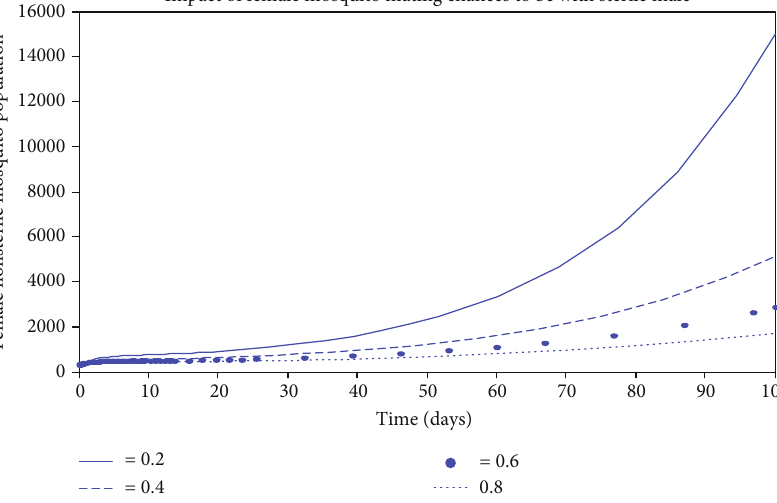
Figure 2: Impact of female mosquito mating probability ð ρ s Þ to be with the sterile male on the female nonsterile mosquitoes; as this rate increases, the population of the female nonsterile mosquitoes is